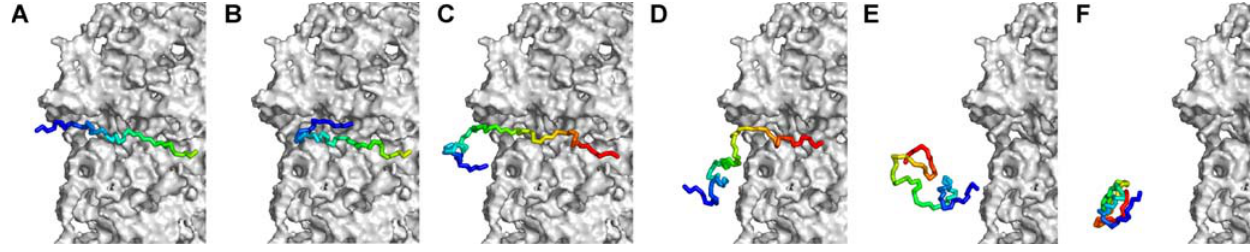
Figure 3. A Coupled Synthesis–Folding Simulation of CI2 Snapshots from a typical de novo folding simulation of CI2 in the presence of the ribosome (grey surface). The nascent chain is colored from blue (N- terminus) to red (C-terminus). Snapshots (A–F) are for timepoints 3.6 l s, 4 l s, 6 l s, 6.04 l s, 6.08 l s, and 6.23 l s, respectively; the length of the nascent protein in (A) and (B) is 40 and 44 residues, respectively, in all other panels, it is full length. This figure was prepared with PyMOL [95]. DOI: